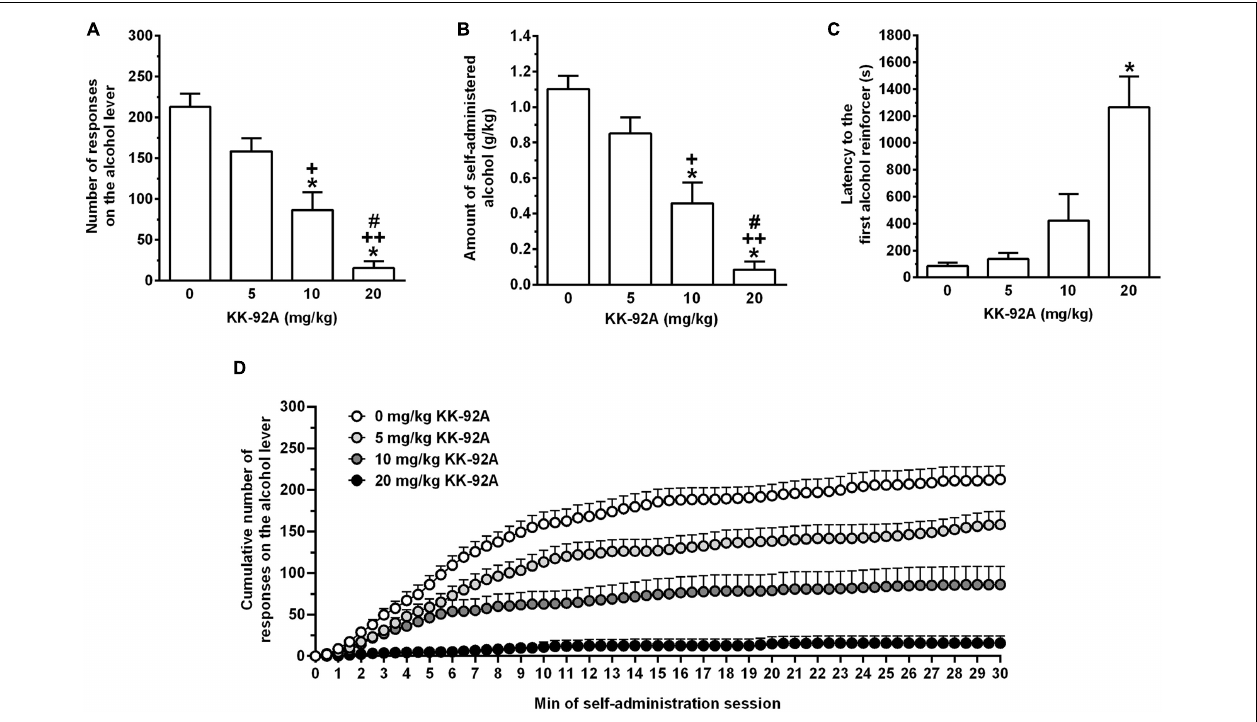
FIGURE 1 | Effect of acute treatment with the positive allosteric modulator of the GABA B receptor, KK-92A, on number of lever-responses for alcohol (A) , amount of self-administered alcohol (B) , latency to the first reinforcer on the alcohol lever (C) , and cumulative response patterns of alcohol self-administration (D) in female Sardinian alcohol-preferring rats. Rats were initially trained to lever-respond for oral alcohol (15% v/v in water) [Fixed Ratio (FR) 5 (FR5)] and water (FR1) in daily 30-min self-administration sessions. Once lever-responding had stabilized, rats were tested with KK-92A under the same FR schedule of reinforcement. KK-92A was administered intraperitoneally 30 min before the start of the self-administration session. In panel (D) , the self-administration session was divided into 30 intervals of 1 min each. Each bar or point is the mean ± SEM of n = 12 rats. * P < 0.0001 in comparison to the rat group treated with 0 mg/kg KK-92A [Tukey’s test in panels (A,B) ; Dunn’s test in panel (C) ]; + P < 0.05 and ++ P < 0.0001 in comparison to the rat group treated with 5 mg/kg KK-92A (Tukey’s test); # P < 0.05 in comparison to the rat group treated with 10 mg/kg KK-92A (Tukey’s